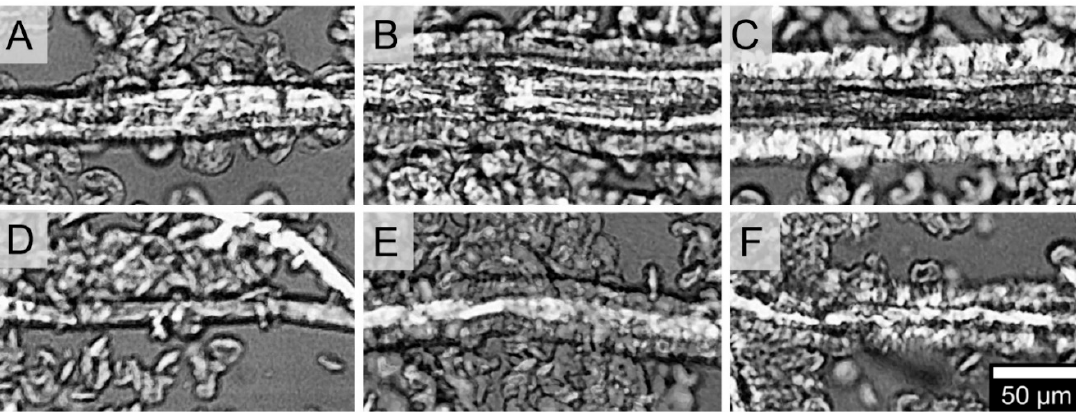
Figure 1. Optical micrographs of iPP trans-crystallisation around High Temperature Thermo- Figure1. OpticalmicrographsofiPPtrans-crystallisationaroundHighTemperatureThermo-Mechanical Mechanical Pulp fibres (HT TMP) and Tencel™ fibres with different sizing. The images are taken after Pulp fibres (HT TMP) and Tencel ™ fibres with di ff erent sizing. The images are taken after a cooling a cooling period (10 °C min-1 ramp) and 5 min of isothermal crystallisation at 133 °C. ( A ) HT TMP period (10 ◦ C min-1 ramp) and 5 min of isothermal crystallisation at 133 ◦ C. ( A ) HT TMP only, ( B ) HT only, ( B ) HT TMP + α -NA, ( C ) HT TMP + β -NA, ( D ) Tencel™ only, ( E ) Tencel™ + α -NA, ( F ) Tencel™ TMP + α -NA, ( C ) HT TMP + β -NA, ( D ) Tencel ™ only, ( E ) Tencel ™ + α -NA, ( F ) Tencel ™ + β -NA. Scale + β -NA. Scale bar = 50 µm. bar = 50 µ